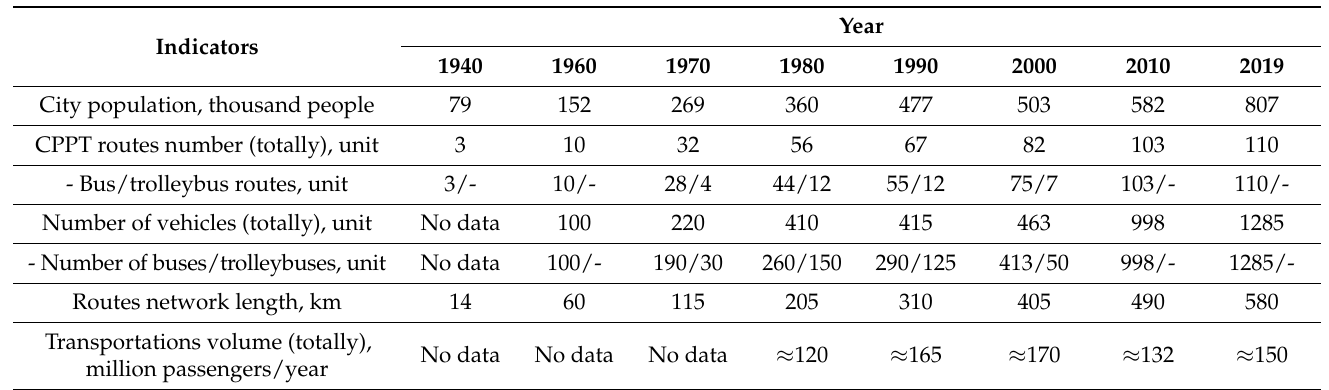
Table 4. Development stages of the Tyumen CPPT system